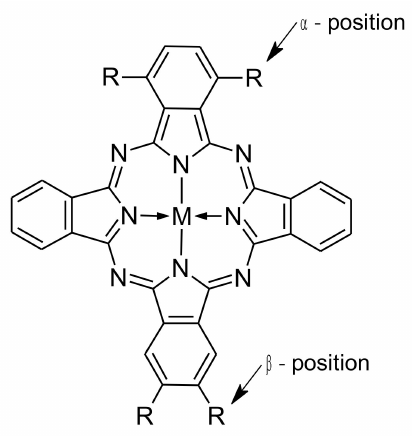
Figure 1. General structure of a phthalocyanine with the non-peripheral ( α ) and peripheral ( β ) substitution positions (M = metal cation or